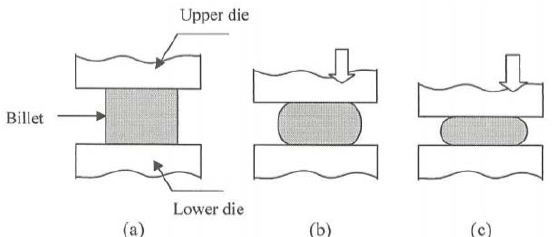
Figure 1: Open die forging (a) Initial condition, (b) and (c) Forging process [5]